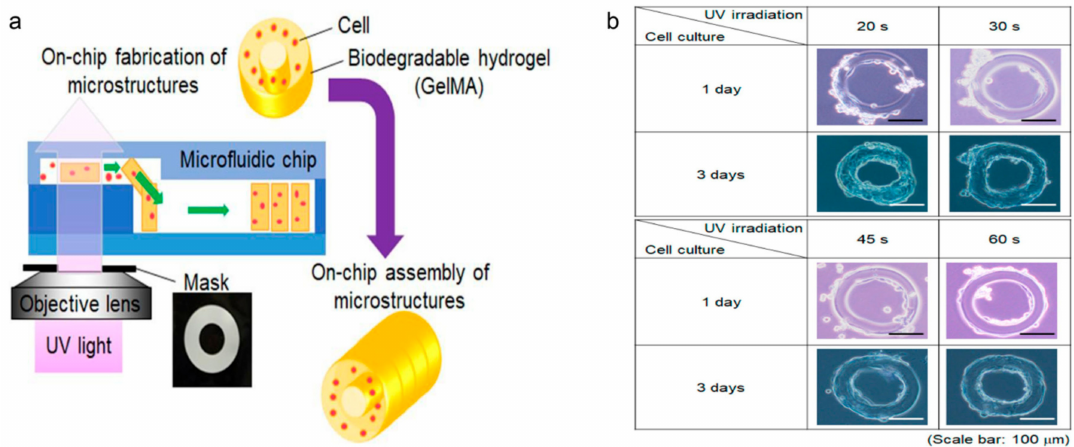
Figure 3. ( a ) Fabrication procedure of tubular microstructures using on-chip fabrication and the assembly of toroidal cell-embedded microstructures. ( b ) Cell culture on GelMA microstructure after 2 days of di ff erent UV exposure. Reproduced with permission